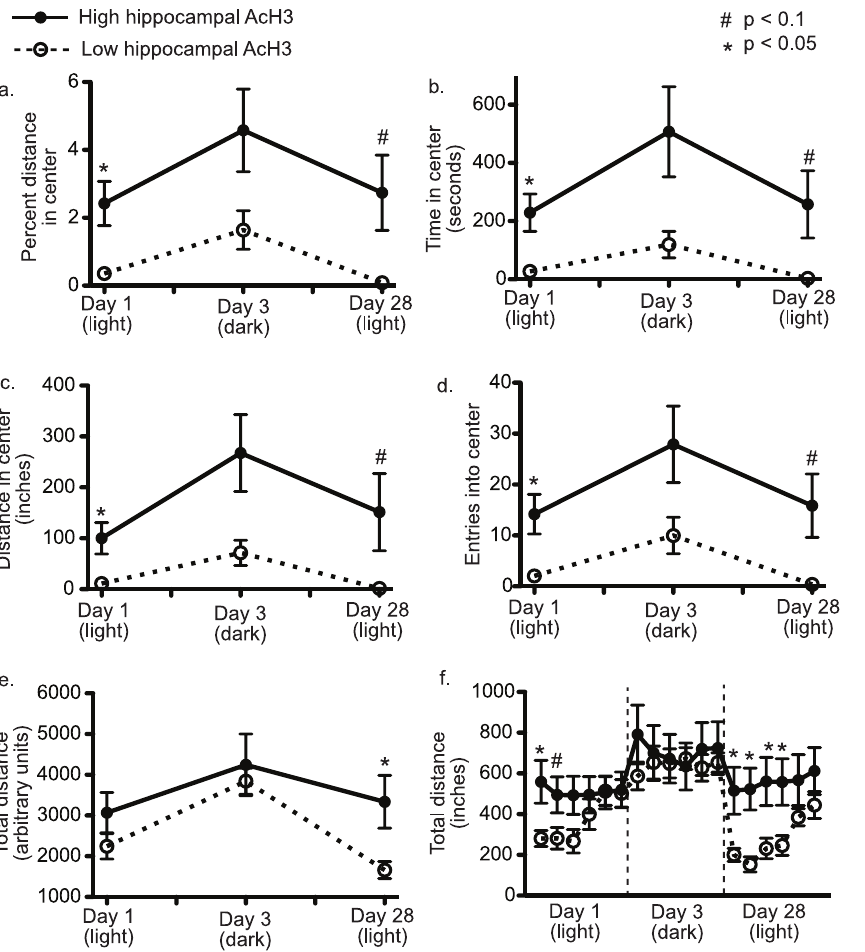
Figure 3. Levels of AcH3 in the hippocampus predict levels of anxiety-like behavior. Mice were split at the median by hippocampal AcH3. Groups of mice separated by hippocampal AcH3 were significantly different in nearly all center measures (Percent distance in center (a), Time in center (b), Distance in center (c), Entries into center (d)) on all testing days. Differences decreased for total distance travelled (panel e), especially when testing was done in the dark. Panel (f) shows a more detailed time course for Total distance by 5-minute bins. Figure shows that differences between groups were most pronounced at the beginning of sessions in the light, whereas, differences decreased in the dark and towards the end of sessions.